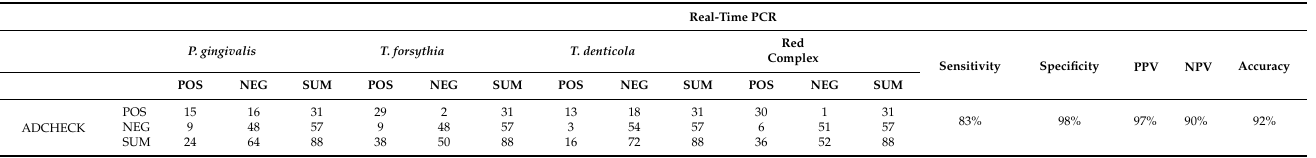
Table 3. Comparison of ADCHECK and real-time PCR in clinical